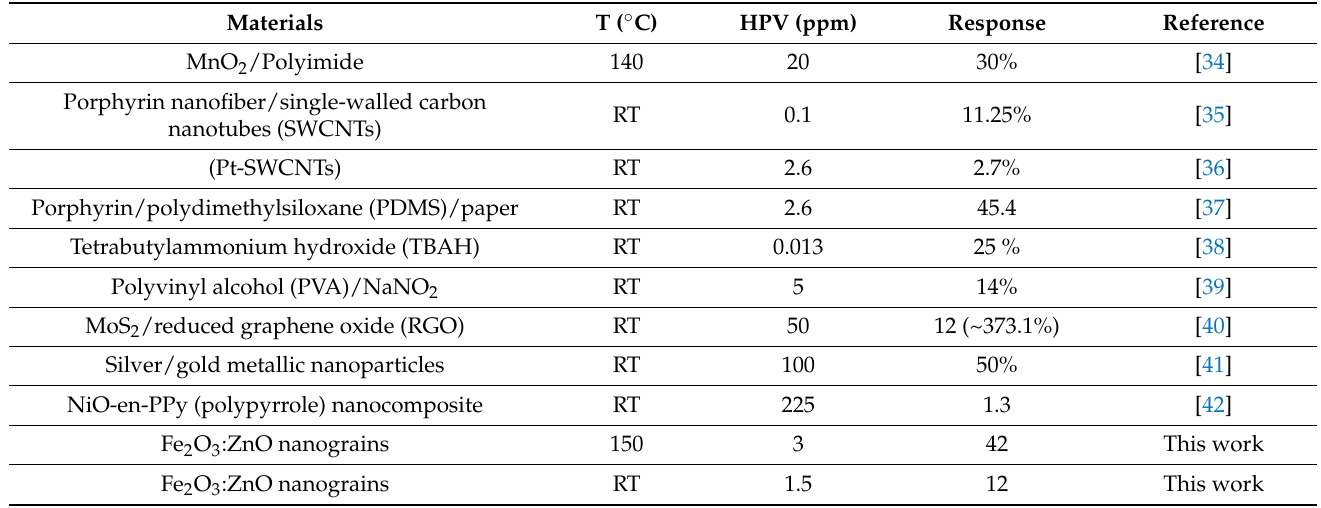
Table 2. The comparison of HPV sensing performance of the Fe 2 O 3 :ZnO material with the perfor- mance of previously reported